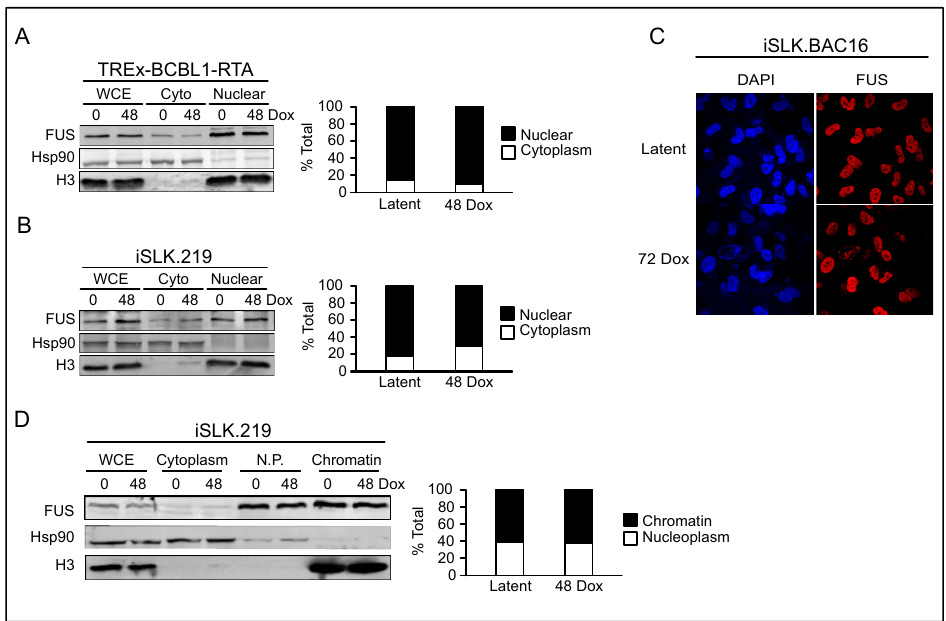
Figure 6. FUS is predominately nuclear in KSHV-infected cells. ( A ) TREx-BCBL1-RTA cells were fractionated at latency and 48 h post-reactivation. WCE: Whole Cell Extract. Cyto: Cytoplasm. Hsp90 is a cytoplasmic control, H3 is a nuclear control. Quantification is to the right of the western blot. ( B ) Fractionation of iSLK.219 cells. ( C ) IF, at 60× magnification, of iSLK.BAC16 cells at latency and 72 h post-reactivation. DAPI is a nuclear marker. ( D ) Chromatin fractionation of iSLK.219 cells at latency and 48 h post-reactivation. WCE: whole cell extract. N.P.: nucleoplasm. Hsp90 is a cytoplasmic control, H3 a nuclear control. Quantification is to the right of the Western blot.